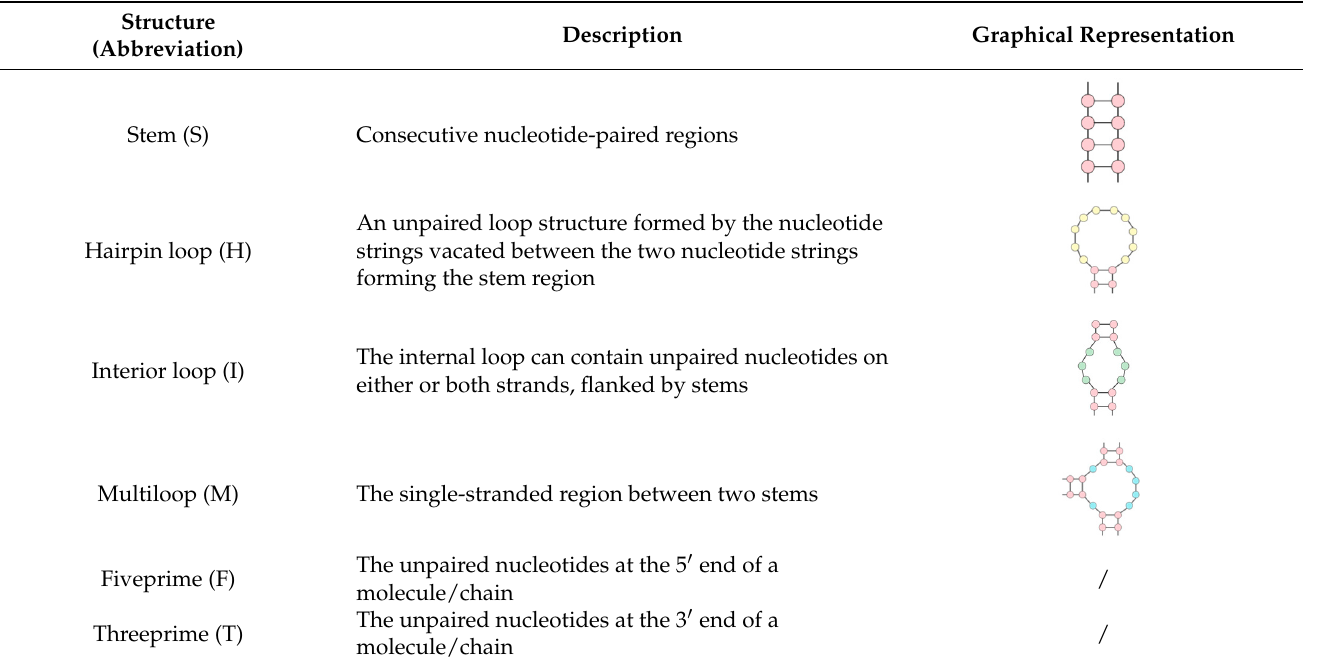
Table 1. Abbreviations, descriptions, and common graphic representations of the six RNA secondary structure types.